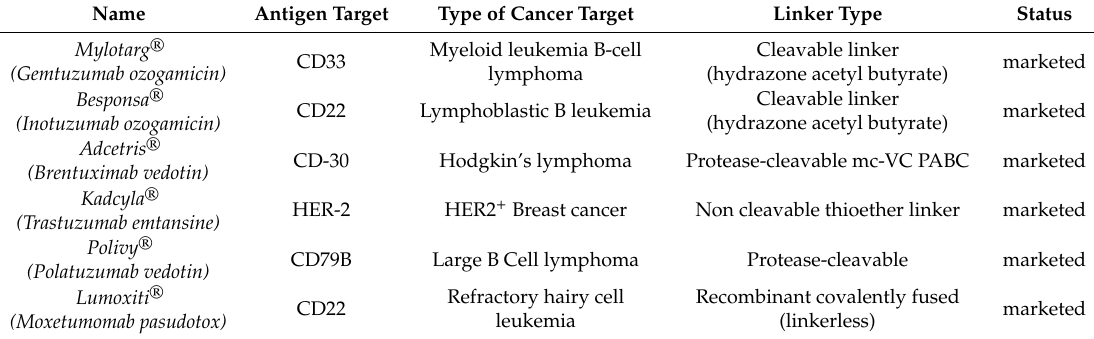
Table 1. ADCs currently approved for clinical